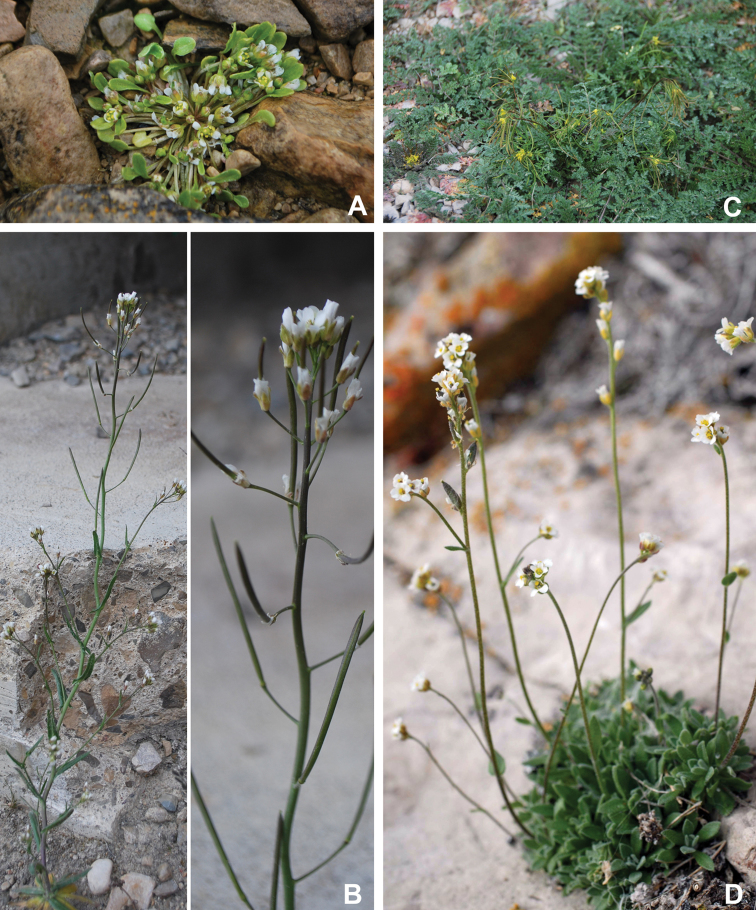
ACochlearia
groenlandica habit BCrucihimalaya
bursifolia habit (left) and inflorescence and fruits (right) CDescurainia
sophioides habit, Saarela & Teeter 5292DDraba
cinerea habit, Gillespie et al 7531. Photos A, B by B.A. Bennett, C by J.M. Saarela and D by R.D. Bull.